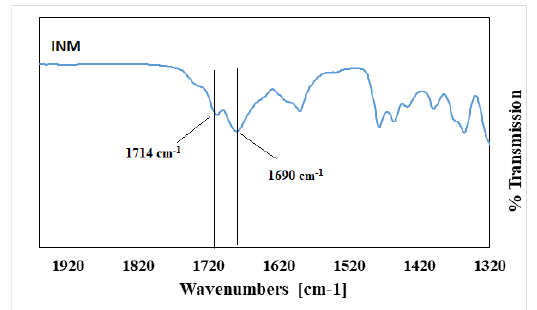
Figure 4. ATR-FTIR Spectrum of crystalline INM.